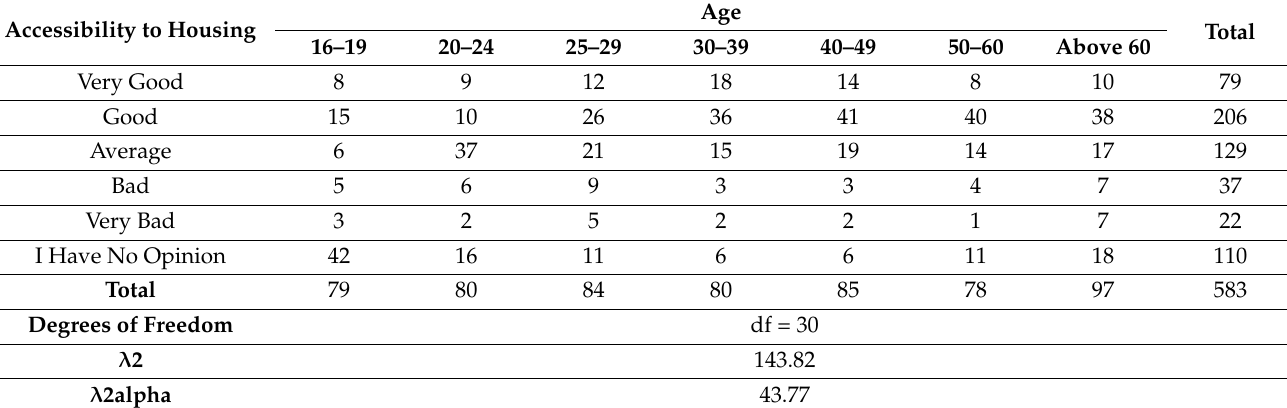
Table 3. Age and accessibility to housing.